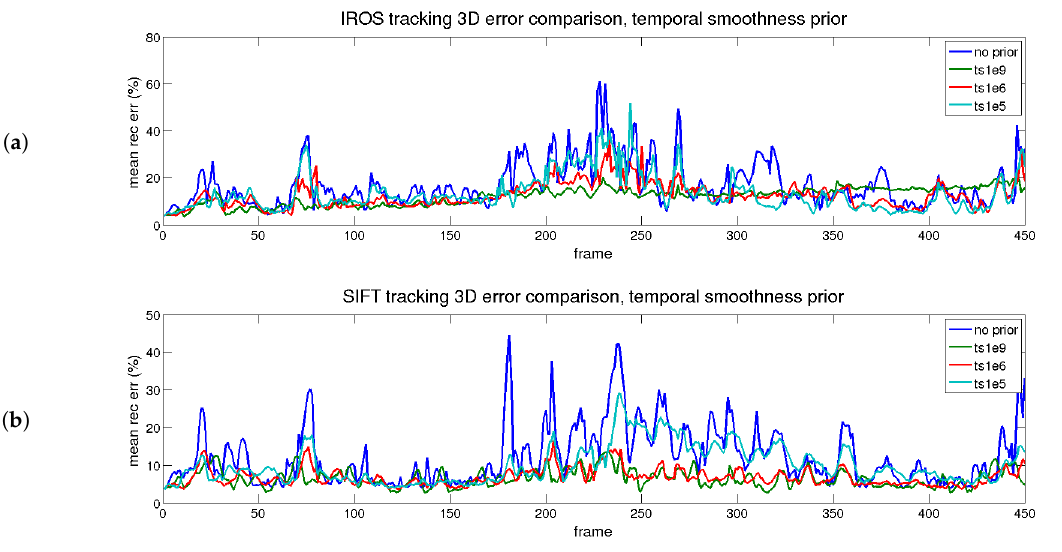
Figure 9. Rendered flag sequence: 3D reconstruction error over time with time smoothness. Results are shown for two types of descriptors. ( a ) IROS; ( b )